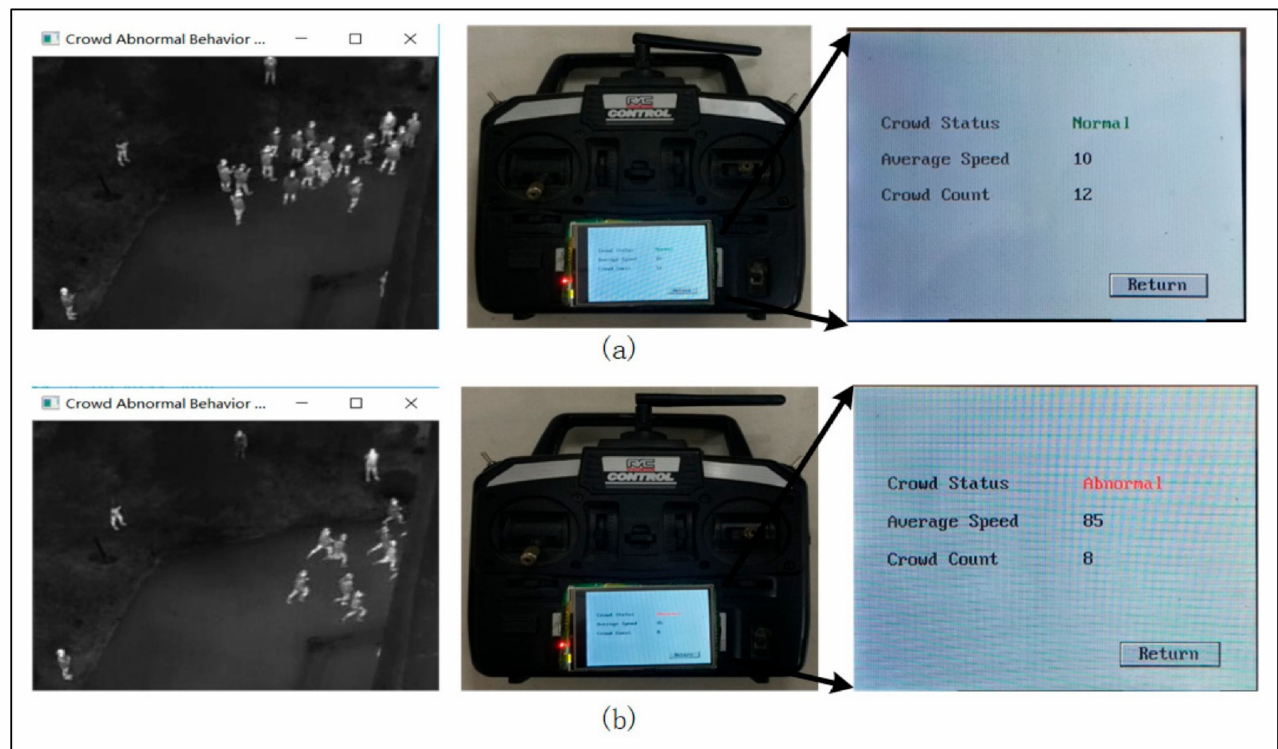
Figure 4. Abnormal behavior detection via drone as demonstrated in [30] on a simulated crossroad scene. ( a ) Normal crowd behavior and ( b ) Abnormal behavior showing increased crowd velocity and crowd escaping